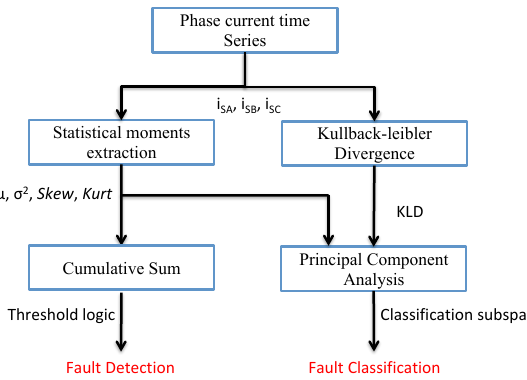
Figure 6. Flowchart of the fault detection and fault classification.